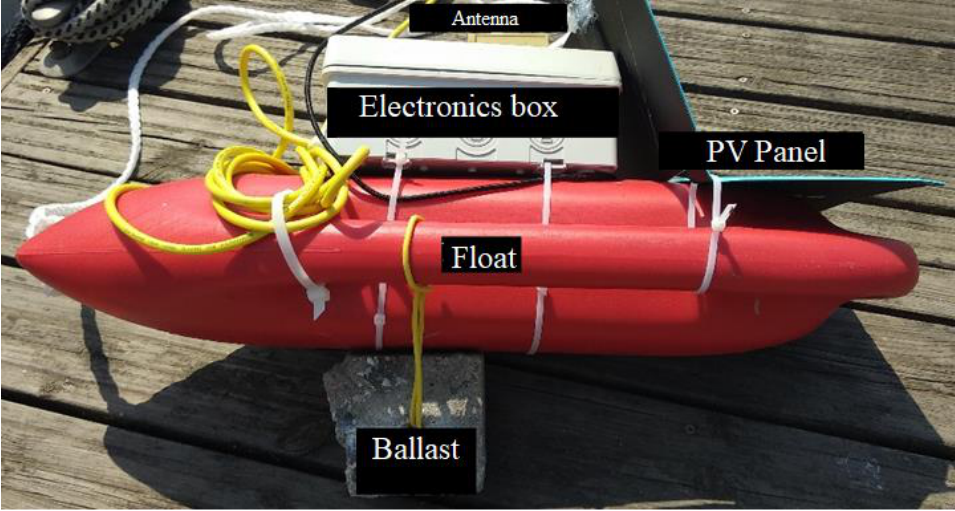
Figure 5. Complete and operational beacon.